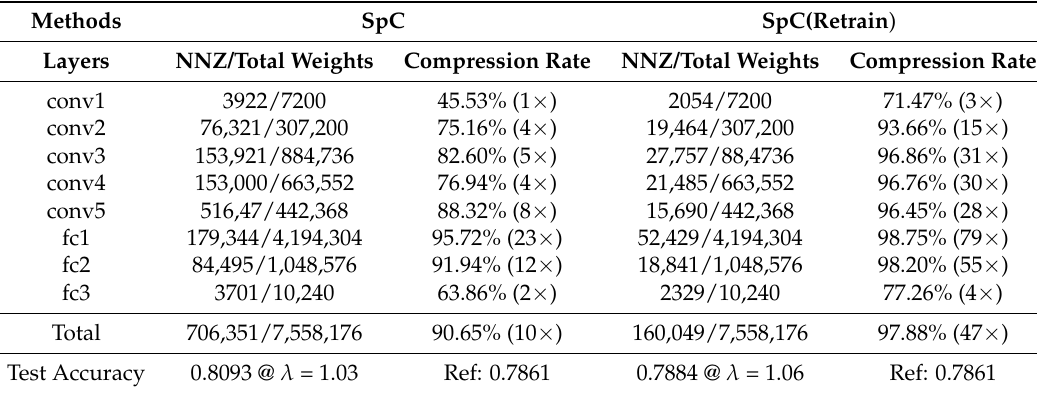
Table A2. Layer-wise compression of AlexNet (CIFAR-10 dataset).